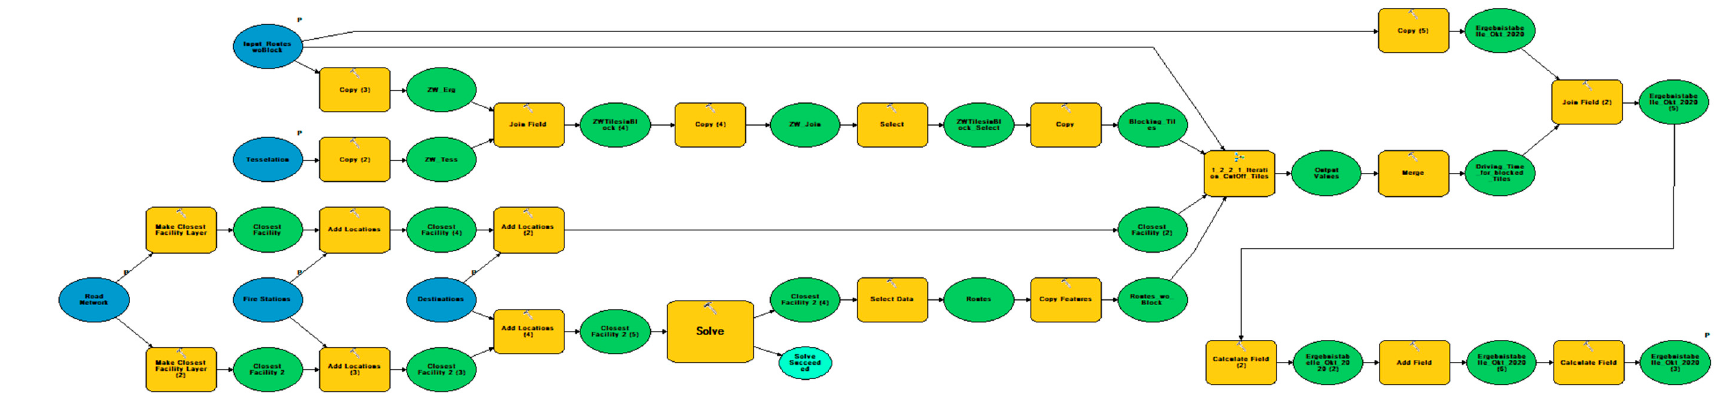
Figure A6. Addition of isolated / cut o ff tiles level in ArcMap ModelBuilder.